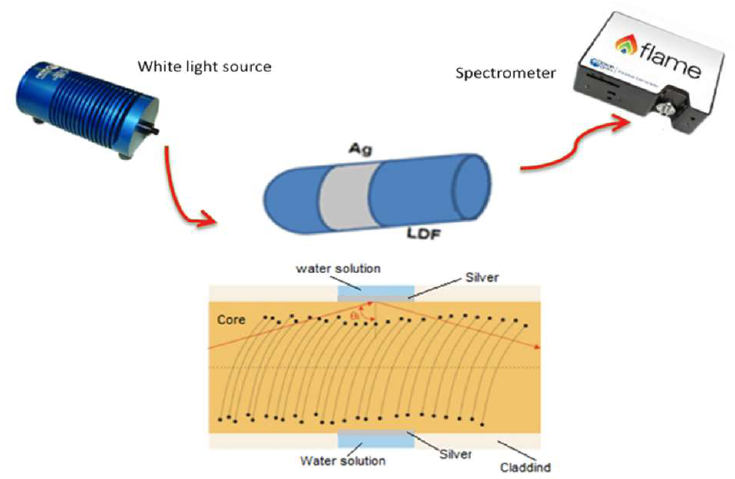
Figure 2. SPR-LDF sensor outline: sensing region with the experimental setup.